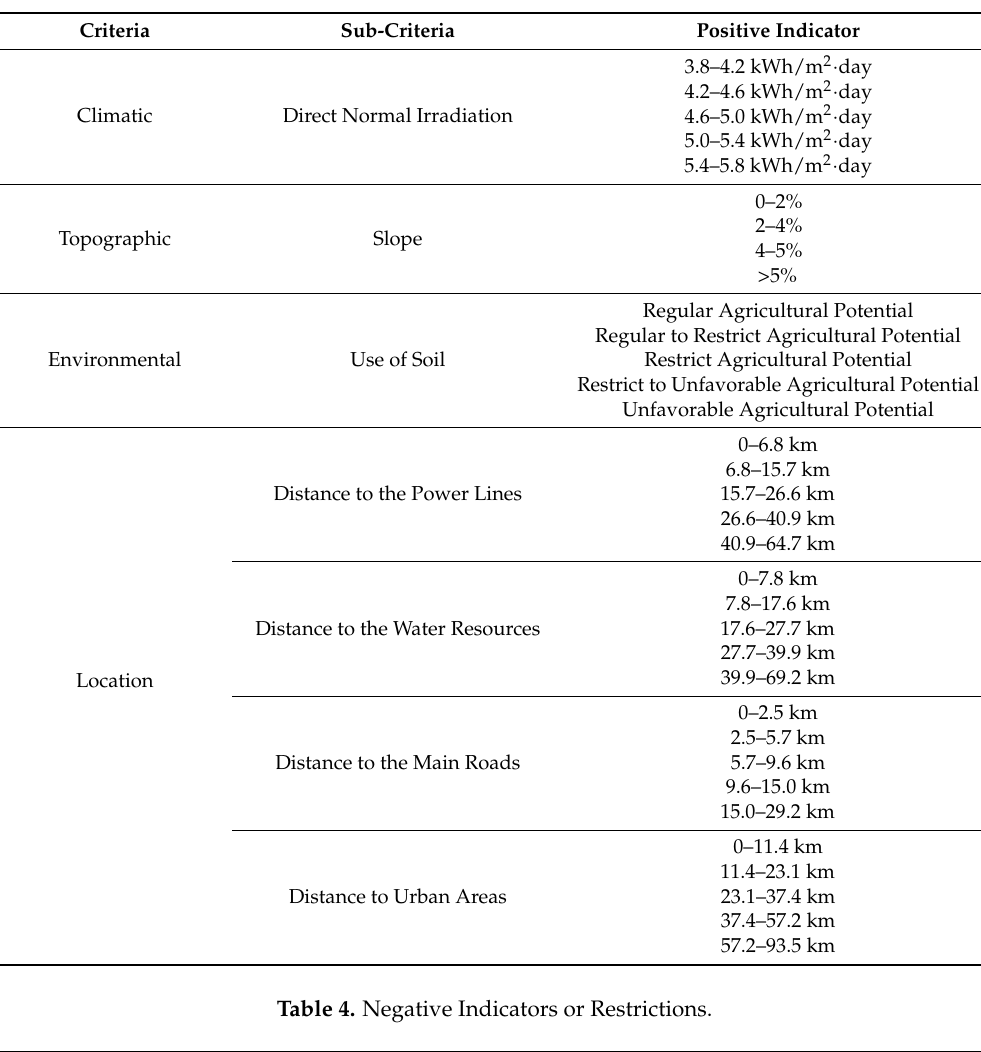
Table 3. Positive Indicators.